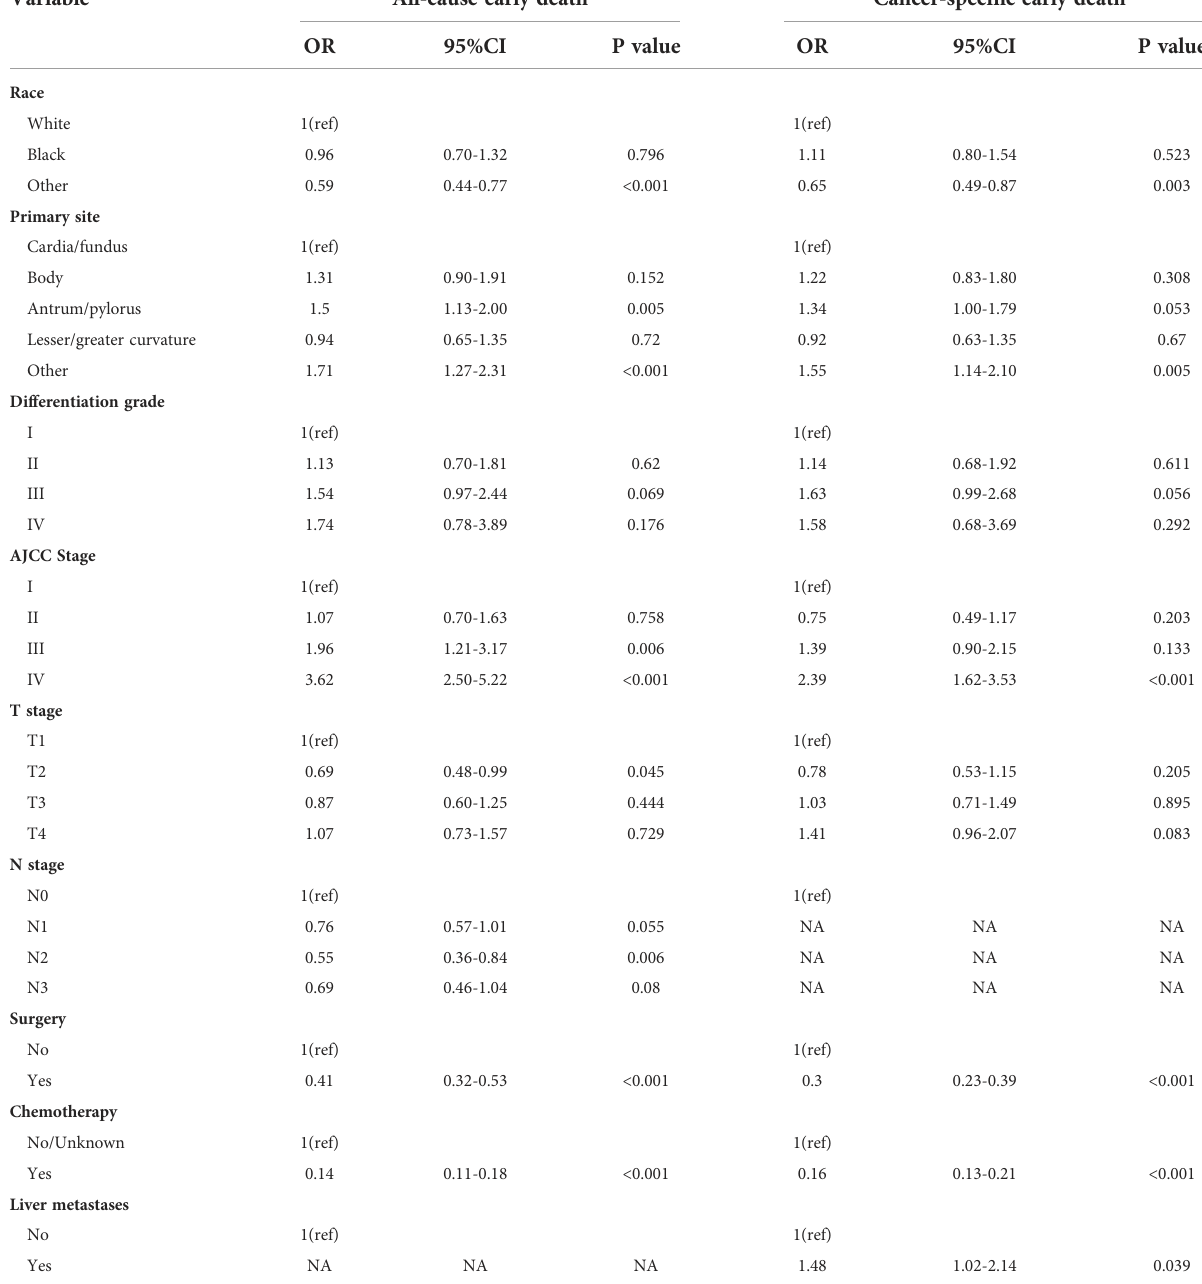
TABLE 4 Multivariate logistic regression for analyzing the risk factors for early